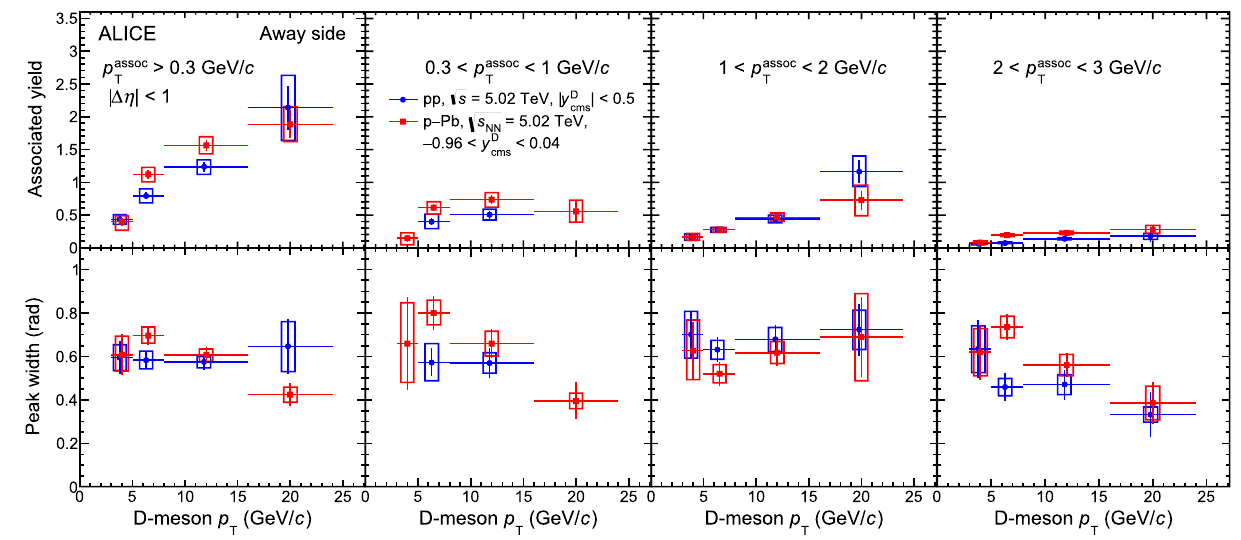
< 3 GeV / c (from left to right). Statistical and system- Fig. 5 Away-side peak associated yields (top row) and widths (bot- and 2 < p assoc √ T s = 5 . 02 TeV and p–Pb colli- tom row) in pp collisions at atic uncertainties are shown as vertical error bars and boxes, respec- √ s NN = 5 . 02 TeV, as a function of the D-meson p T , for tively. The points and error boxes for pp collisions are shifted by sions at > 0 . 3 GeV / c , 0 . 3 < p assoc < 1 GeV / c , 1 < p assoc < 2 GeV / c , = − 0 . 2 GeV / (cid:4) p p assoc T T T T